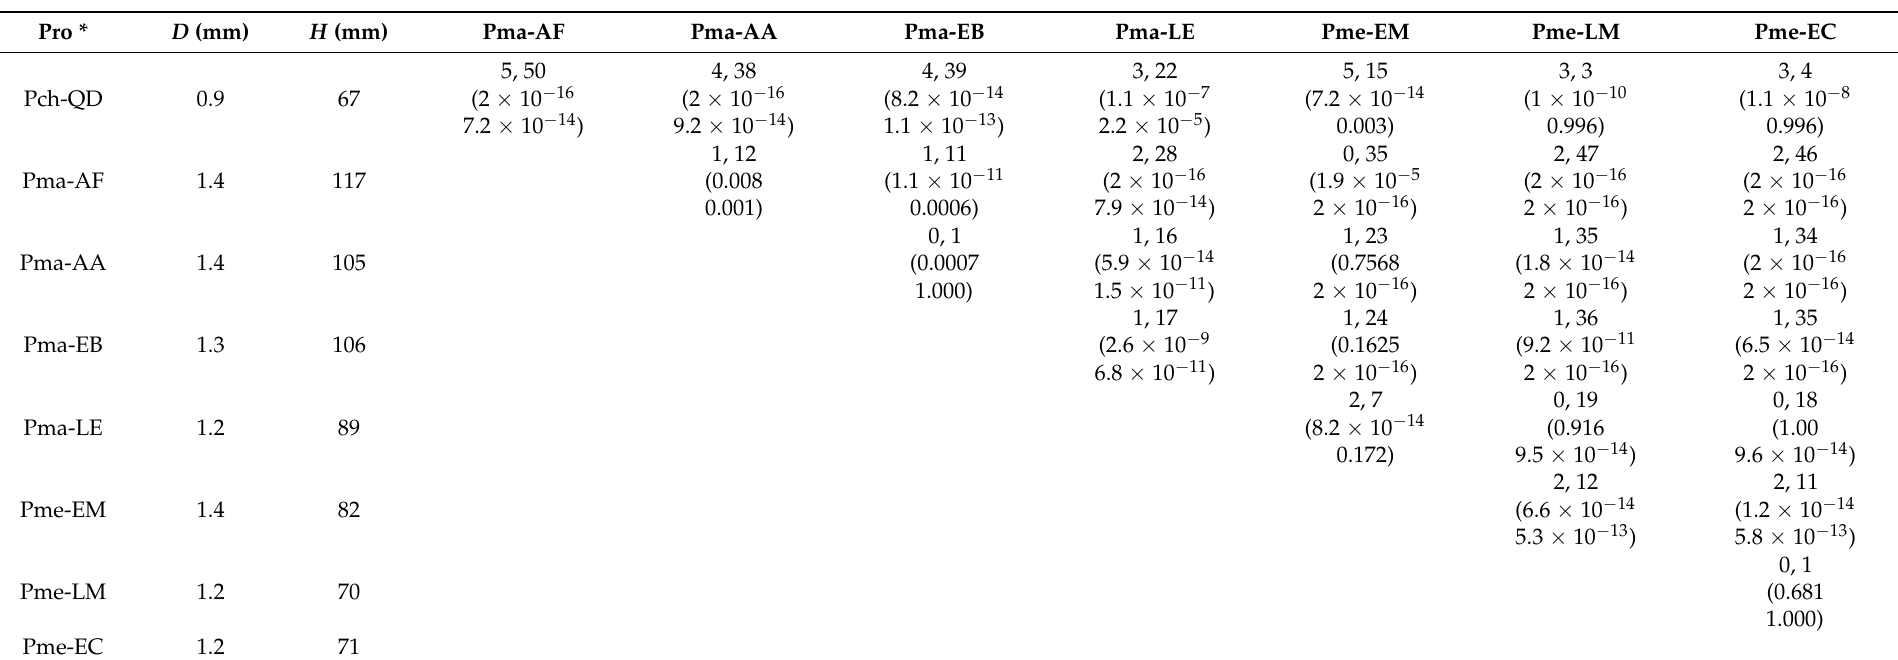
Table 5. Absolute differences in mean diameter ( D ) and height ( H ) among the eight provenances of three Mexican spruces and respective p -values for differences in H and D (in brackets) (* Pro = provenances of: Pch-QD = Picea chihuahuana -Quebrada de los Dur á n, Pma-AF = Picea martinezii -Agua Fr í a, Pma-AA =